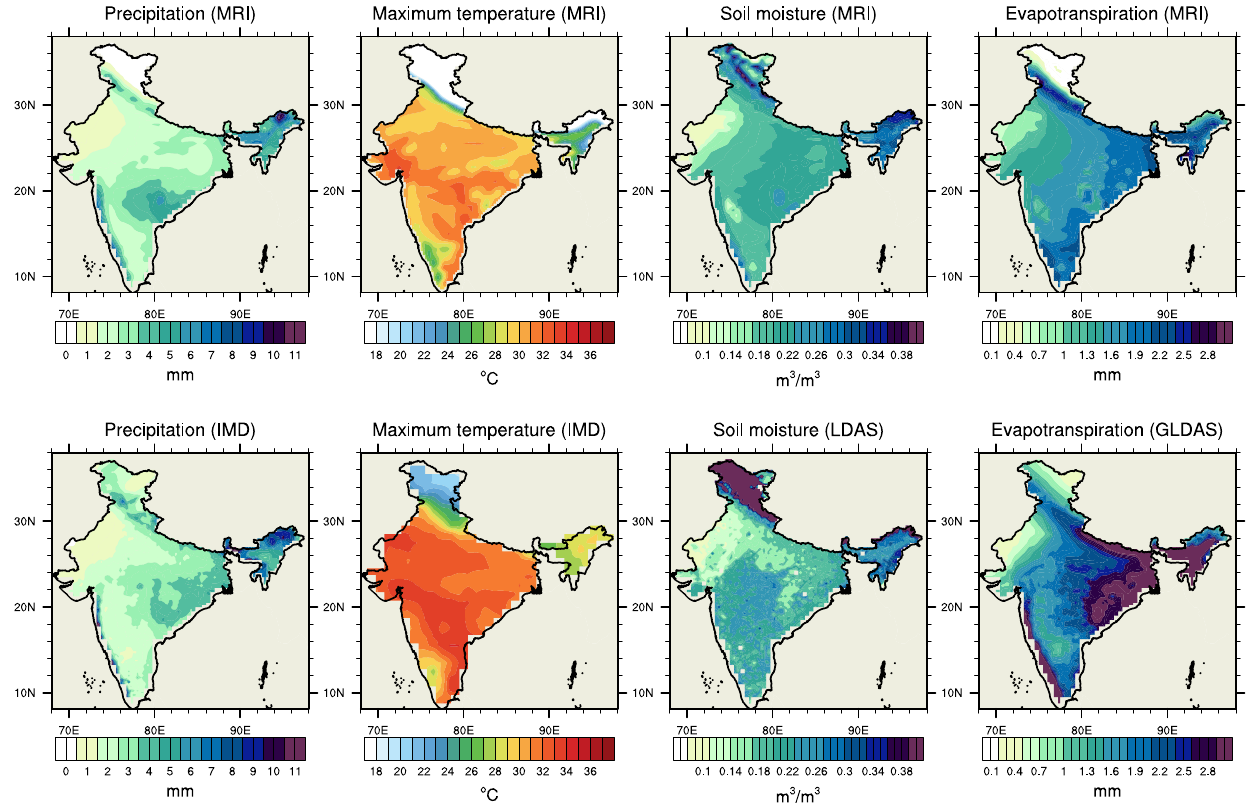
Fig. 1 Climatological features of hydro-meteorological variables for period 1951 – 2010. Time-mean spatial maps of annual mean precipitation (1 st column), maximum temperature (2 nd column), soil moisture (3 rd column) and evapotranspiration (4 th column) from the model simulations (1 st row) and other data products (2 nd row) for the historical period (1951 – meteorological variables. Fig. 2 shows the Taylor diagram 37 analysis of PR, SM, T max and ET averaged over the Indian region based on the bias-corrected model outputs (left panel), and raw (uncor- rected) model simulations (right panel). The results of the Taylor diagram analysis suggest that the bias-corrected PR, SM, T max and ET over the Indian landmass simulated by the model compares well with observations w.r.t correlation, standard deviation, and root mean square error. It can be seen that the annual-mean bias- corrected hydro-meteorological variables show high correlations in the range of (0.75 – 0.91), standard deviations close to the